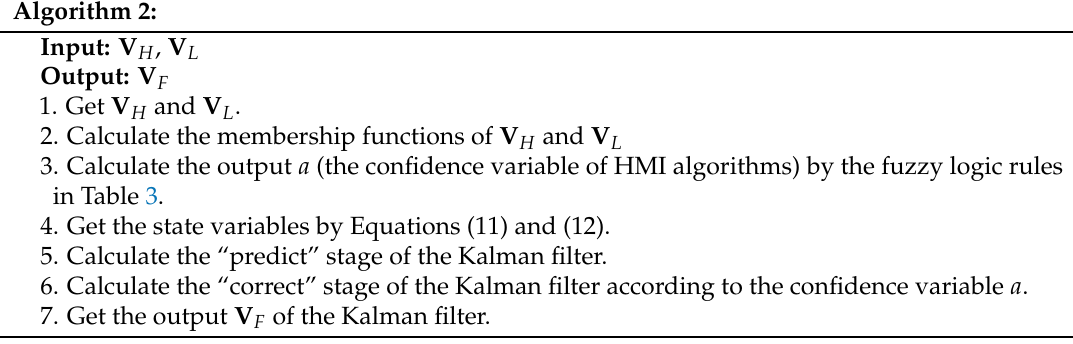
Table 3. Rules table for a. negative big (NB), negative medium (NM), negative small (NS), zero